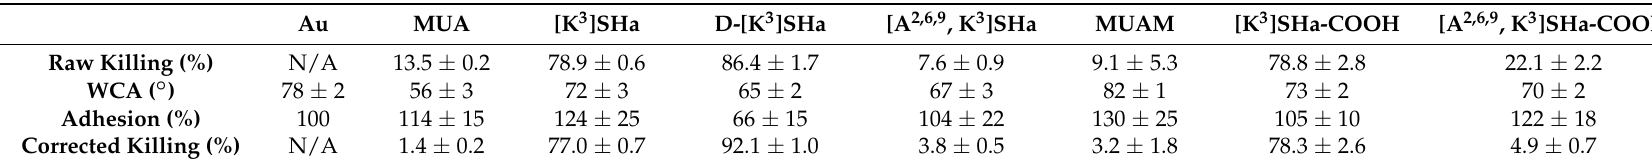
Table 4. Bacterial killing, water contact angle (WCA) and bacterial adhesion of the different modified surfaces (SAM with and without grafted temporin) compared to bare gold surface. Raw Killing (killing without adhesion correction) and corrected killing (killing with adhesion correction) are both